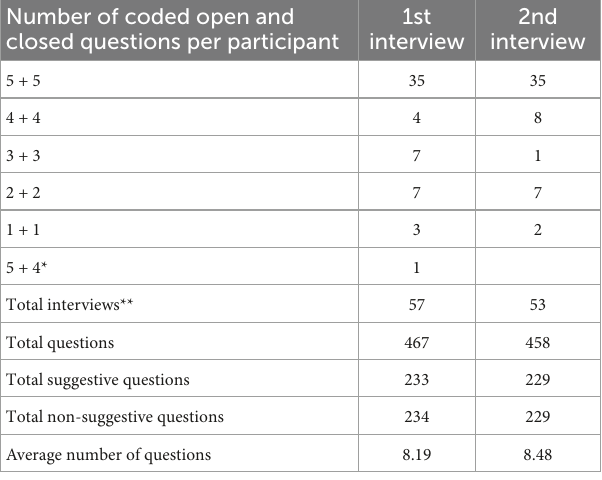
TABLE 2 Number of coded questions in 1st and 2nd